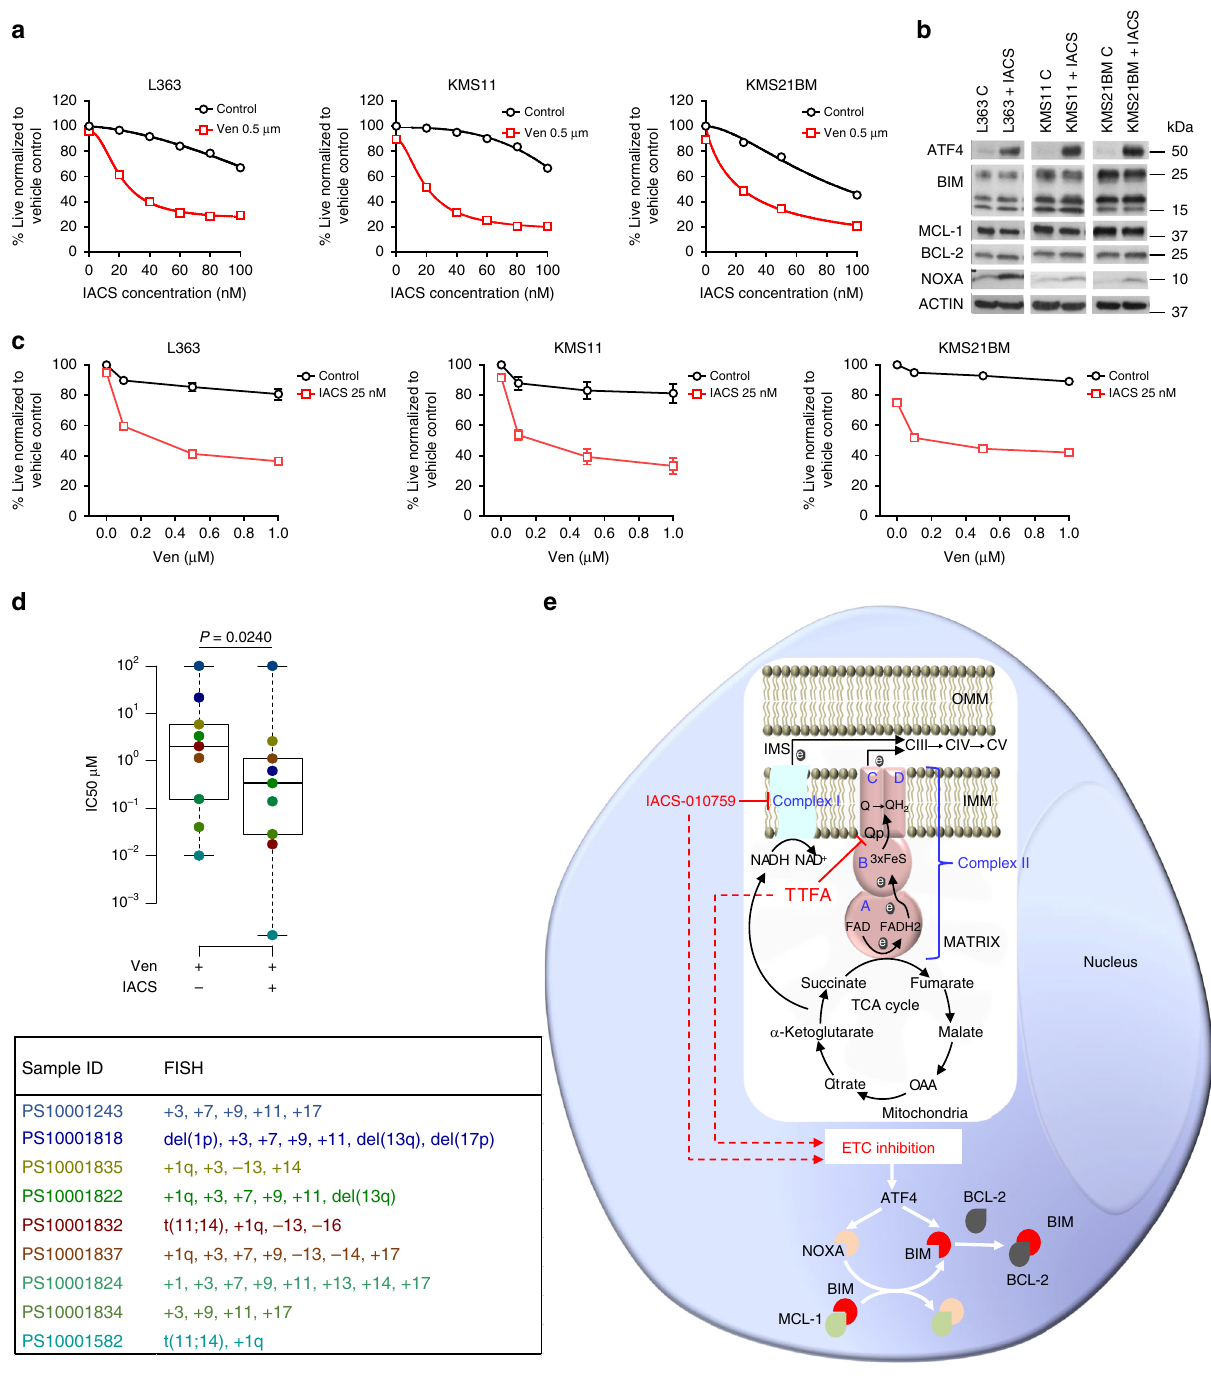
Fig. 7 Inhibition of Complex I with IACS-010759 sensitizes resistant MM to venetoclax. a Dose − response curves for cotreatment of indicated cell lines with 0.5 µ M venetoclax and increasing doses of IACS-010759 for 24 h. Cell viability assessed by AnnexinV/DAPI fl ow cytometric staining. b Expression of ATF4 and the indicated pro- and antiapoptotic proteins were evaluated in whole-cell lysates of the indicated lines treated ±25 nM IACS-010759 for 24 h. Actin was assessed as a loading control. Representative blots from one of two independent experiments is presented. c Dose − response curves for cotreatment of 25 nM IACS-010759 with increasing doses of venetoclax. Cell viability assessed by AnnexinV/DAPI staining. n = 3 independent experiments. Data are presented as mean values ± SEM. d Box plot of IC50 values of Ven and Ven + IACS, and table with FISH characteristics of nine myeloma patient samples. n = 9 biologically independent samples. Boxplots show the median and quartiles with the whiskers extending to the most extreme data point within 1.5 times the interquartile range. PS10001243 was resistant to Ven ± IACS and has been represented to have an arti fi cial IC50 of 100 µ M for Ven ± IACS in the box plot. e Mechanistic representation of how Complex I and Complex II regulate BCL-2 dependence in an MM cell. IACS- 010759 and TTFA inhibit Complex I and Complex II, respectively, resulting in ETC inhibition. ETC inhibition regulates BCL-2 dependency by inducing ATF4. ATF4 induces NOXA (light orange) that displaces BIM (red) from MCL-1 (green). The increased binding of BIM to BCL-2 (gray) elevates BCL-2 dependence leading to sensitization to venetoclax. Source data are provided as a source data fi